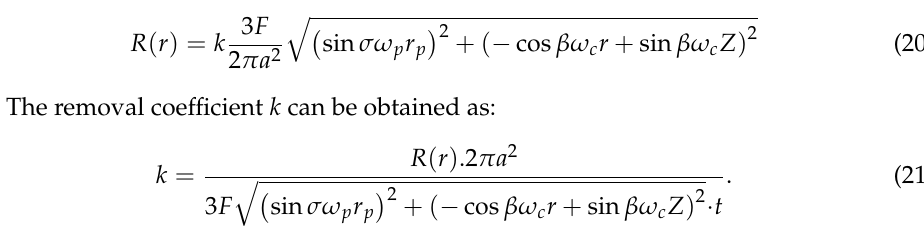
Figure 8. ( a ) Small spherical polishing tool structure; ( b ) Semi-flexible small polishing disc tool structure.